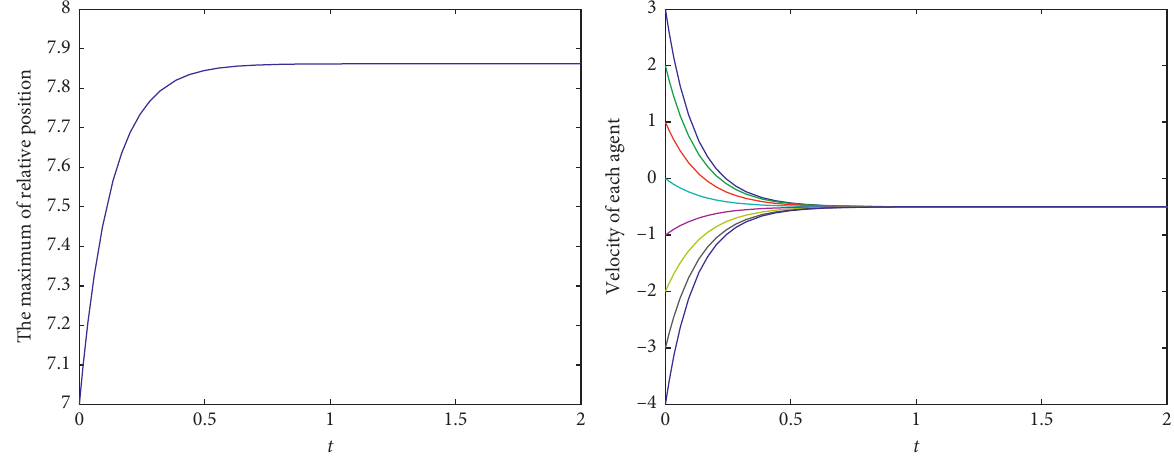
Figure 1: α � 15 , β � 0 . 51 > 0 . 5 , τ � 0. Systems (3) and (4) converge to a flock.